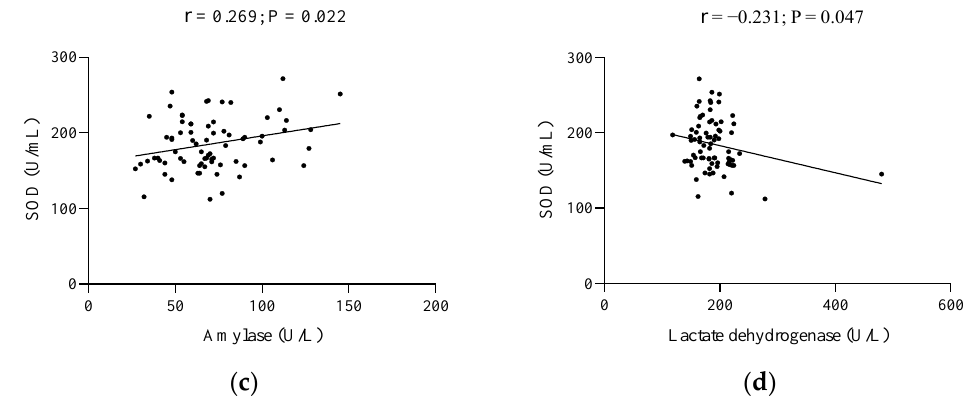
Figure 3. Significant associations of the body composition and biochemical parameters of the study with SOD. ( a ) Vitamin D 3 and SOD, ( b ) Vitamin D 2 and SOD, ( c ) amylase and SOD, and ( d ) lactate dehydrogenase and SOD. r, Pearson’s correlation coefficient. A p -value less than 0.05 was considered significant. Abbreviations: SOD, superoxide dismutase.